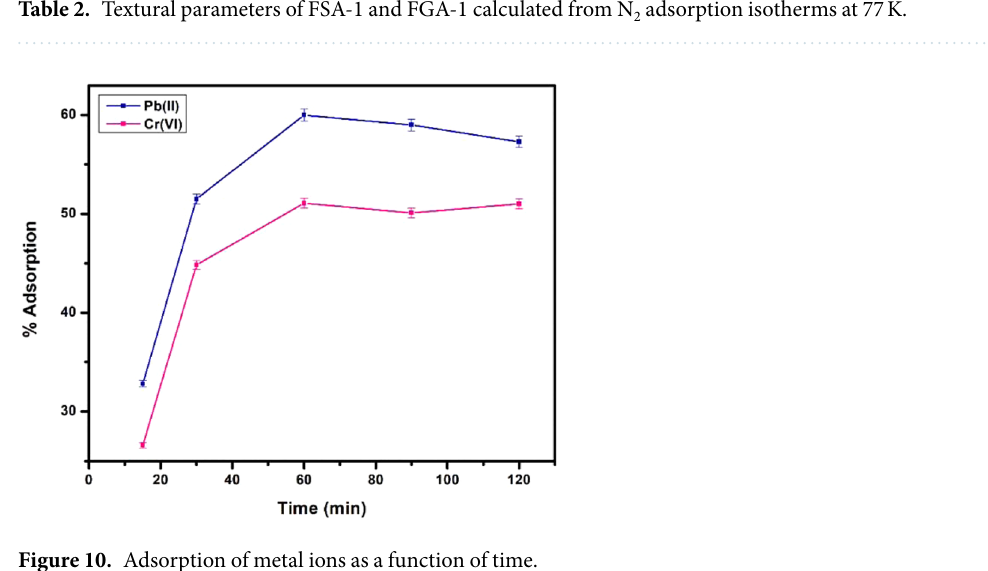
Figure 10. Adsorption of metal ions as a function of